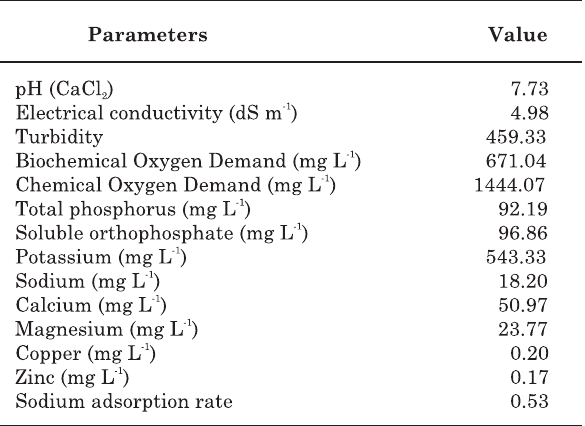
Table 2. Characteristics of the experimental swine